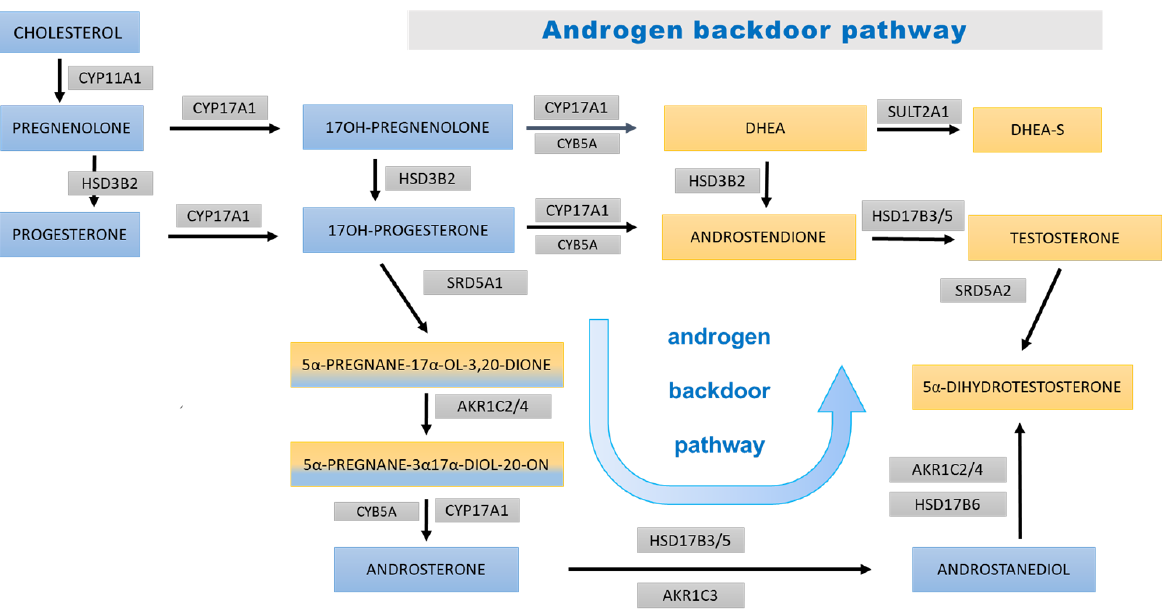
Figure 6. Androgen backdoor steroidogenesis pathway. The blue boxes bear the names of the steroid precursors at early stages of steroidogenesis and for 17OHP and its derivatives; yellow areas (and mixed yellow/blue) are background for androgens and their precursors. The bluish arrows represent steps of the androgen backdoor pathway. The abbreviations of the enzymes involved in each step are displayed in gray boxes: CYP11A1—cytochrome P450 cholesterol monooxygenase (side-